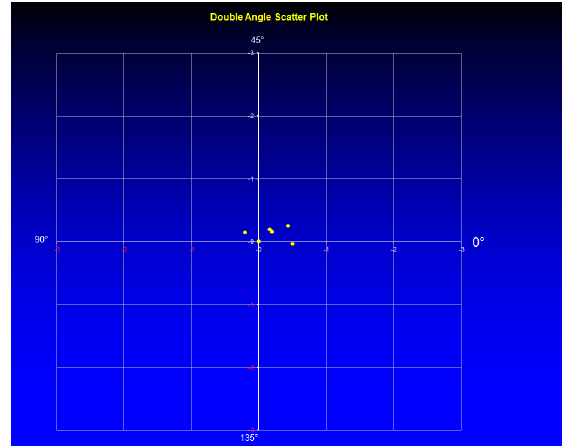
Figure 8. Double angle scatter plot for group 1.